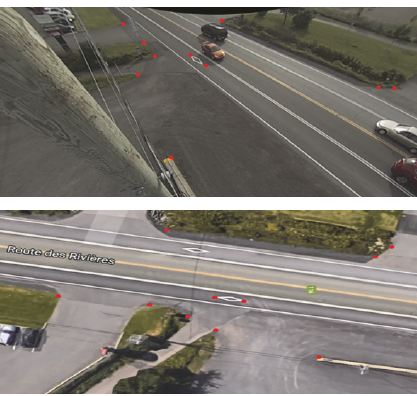
Figure 1: Points selected on the video frame to compute homogra- phy file.